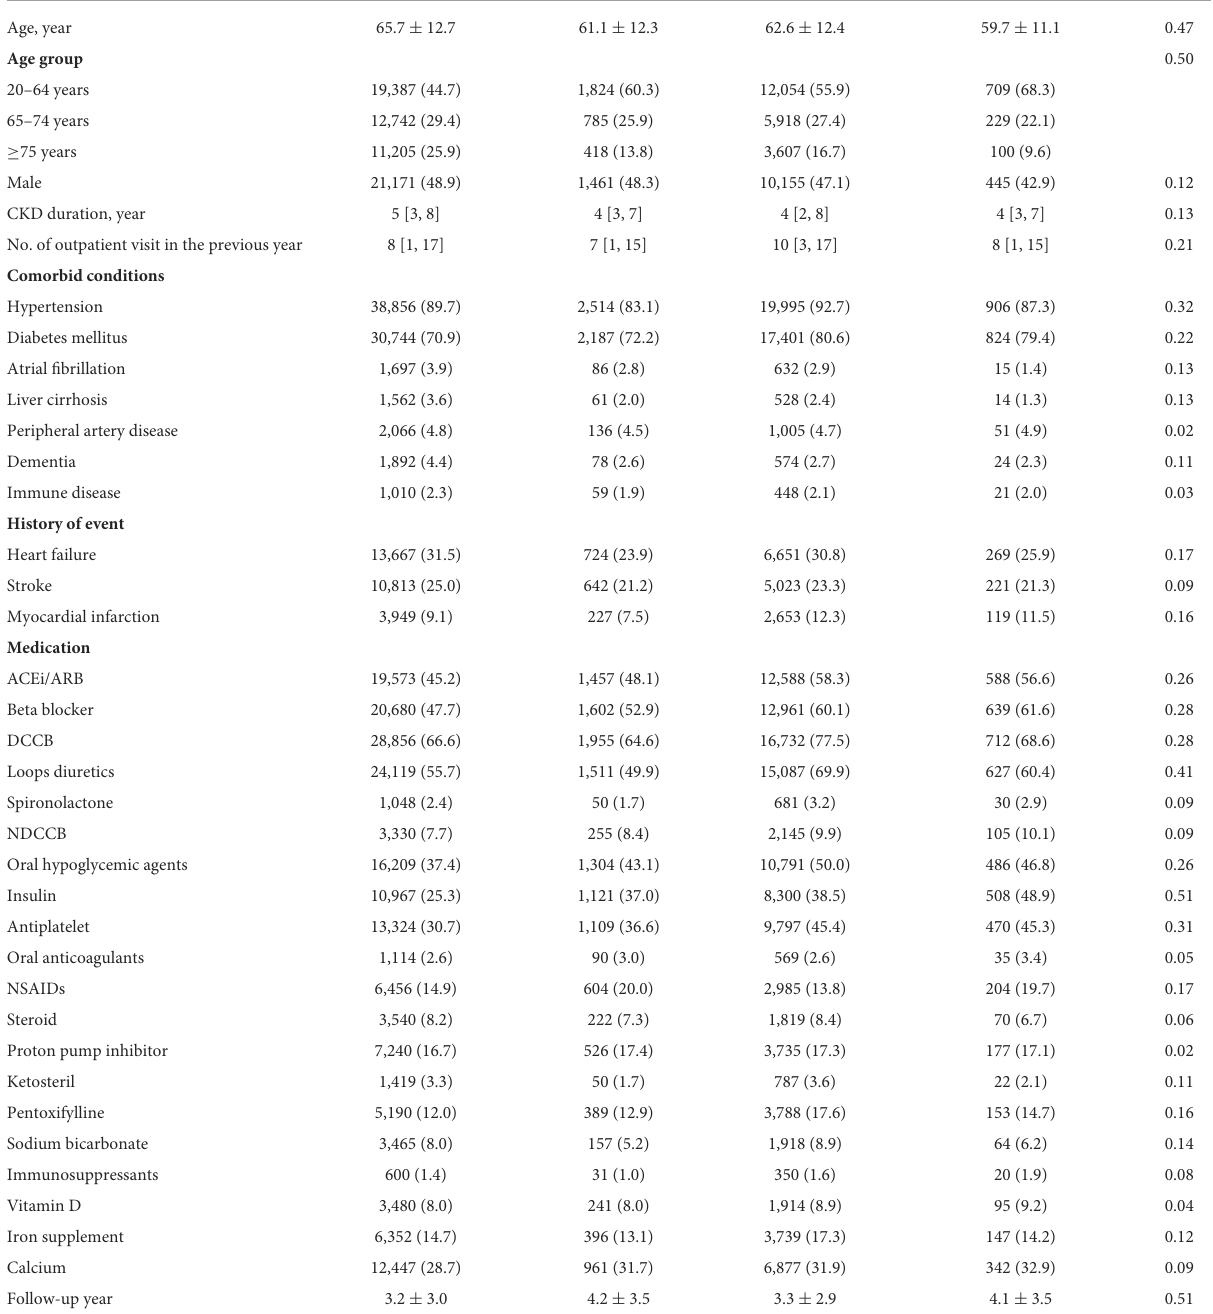
TABLE 1 Baseline characteristics of dialytic patients according to the use of fibrate and statin before IPTW adjustment.